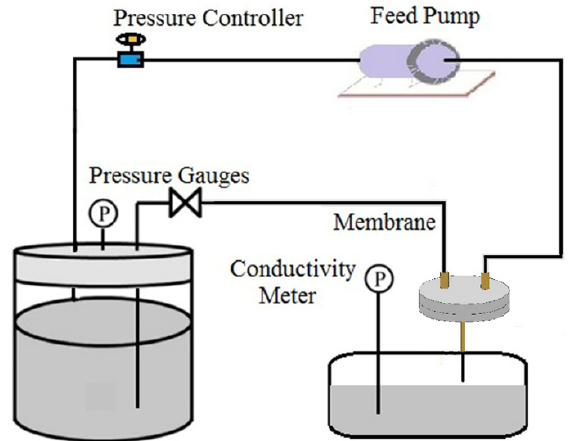
Figure 2. The testing device for the LEP of the dried ultrafine fibrous FEP porous membranes.